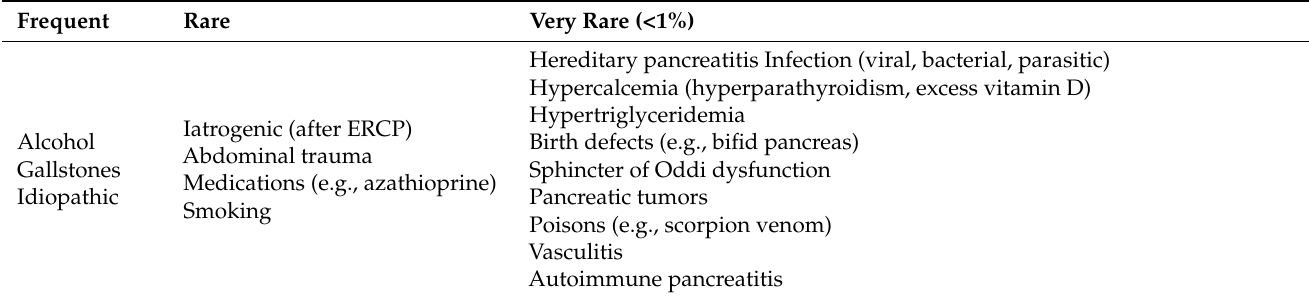
Table 2. The causes of acute pancreatitis [22].